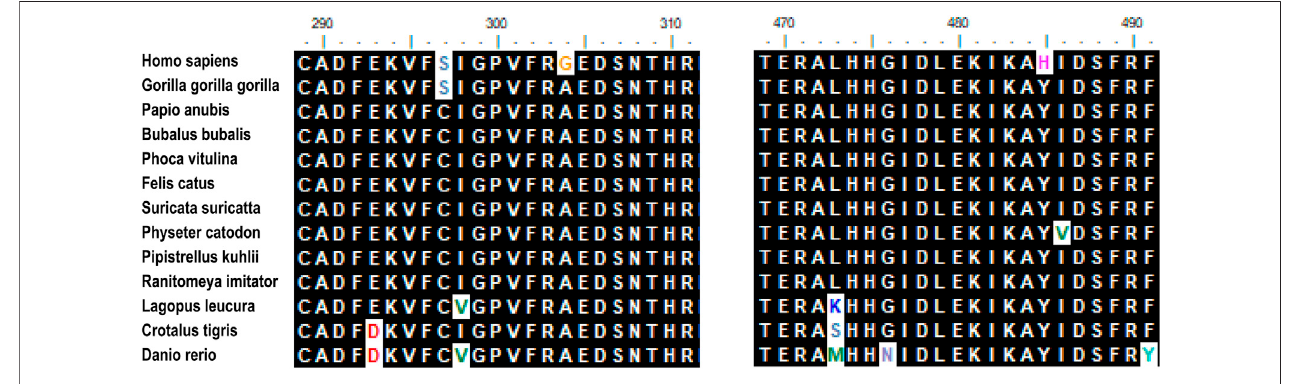
FIGURE 3 | Sequence alignment of the DARS in different species. Comparison of the amino acid sequence show its high conversation among species. Amino acids that differ from the sequence of the insert in humans are indicated in different colors. Mutation site (N304 and N485) are marked in yellow and